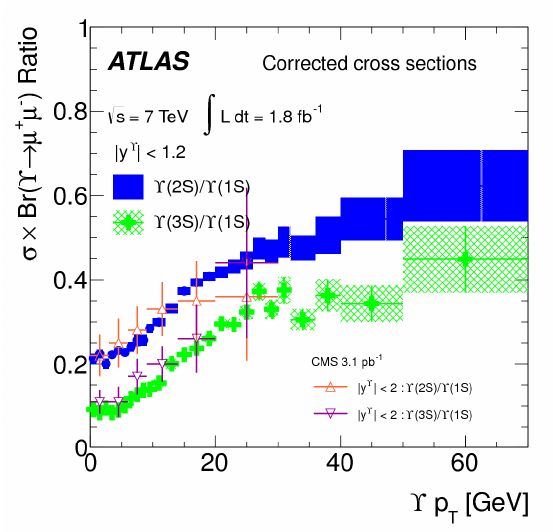
Figure 7: The ratios of di ff erential Υ (2 S ) / Υ (1 S ) and Υ (3 S ) / Υ (1 S ) cross sections multiplied by the di-muon branching fractions versus Υ p T in the central rapidity regions.